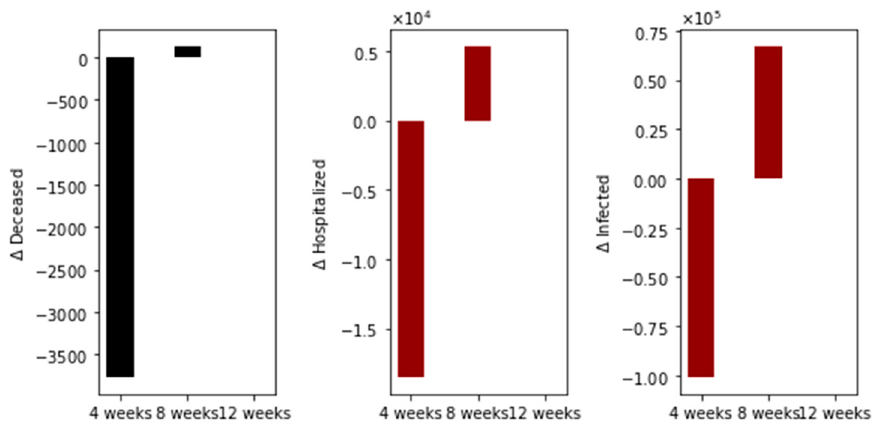
Figure 5. Differences in the total number of deaths, hospitalized, and infected, under the different time interval vaccine regimens. This scenario considers a transmission rate such that the basic reproduction number R 0 is greater than one, the vaccination pace is just 100,000 per day, and the vaccine efficacy after the first dose is 60% and 95% after the second dose.